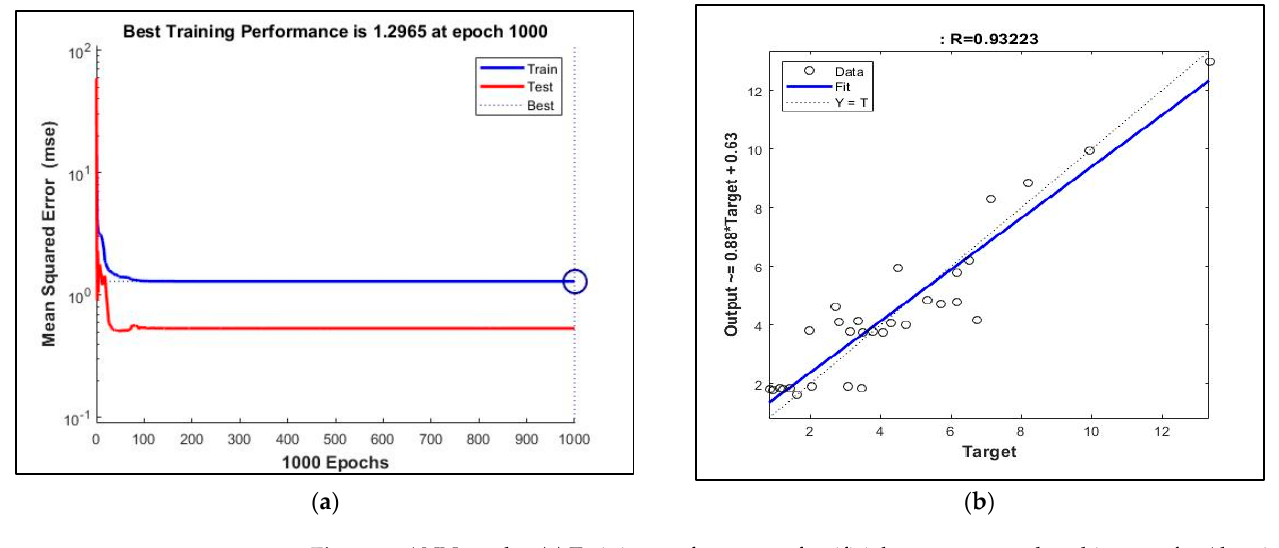
Figure 7. ANN results: ( a ) Training performance of artificial neuron network architecture for Abrasion Coefficient-water absorption. ( b ) The relation between predicted values of artificial neuron network architecture for Abrasion Coefficient-water absorption ( y -axis) and experimental values ( x -axis).